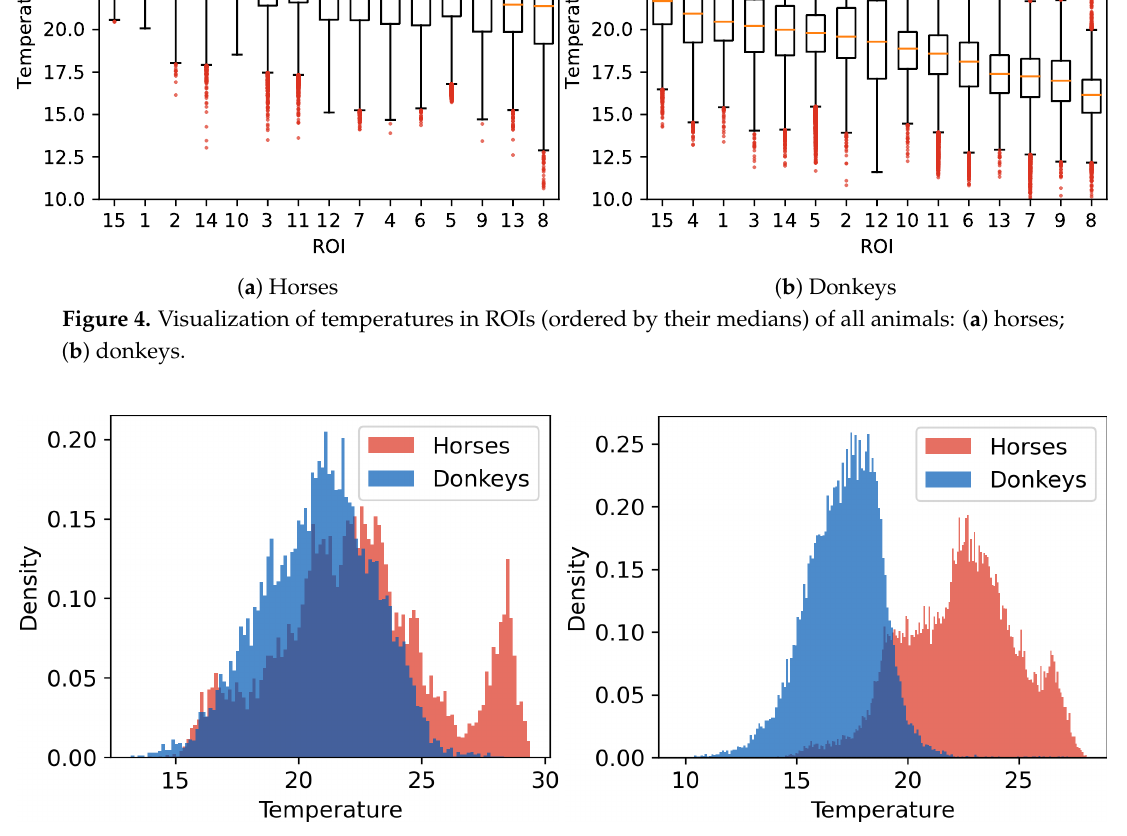
Figure 5. Histograms of temperatures for two ROIs where the difference ∆ t between mean values of temperatures for the two animal species is: ( a ) the smallest (ROI 4, ∆ t = 1.59) and ( b ) the largest (ROI 7, ∆ t =